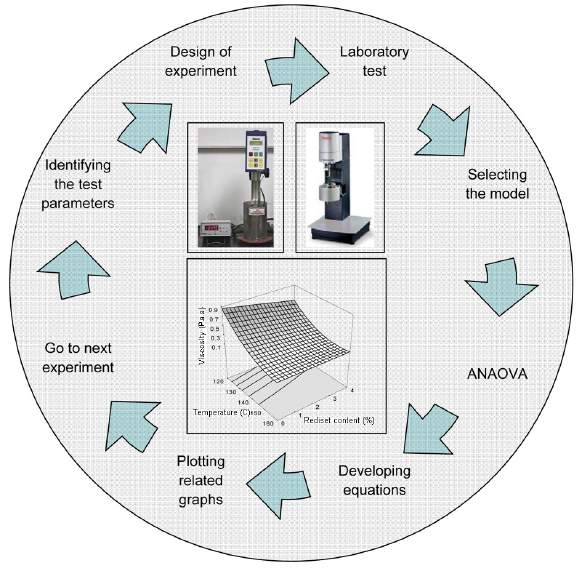
Fig. 1. A schematic sketch of research